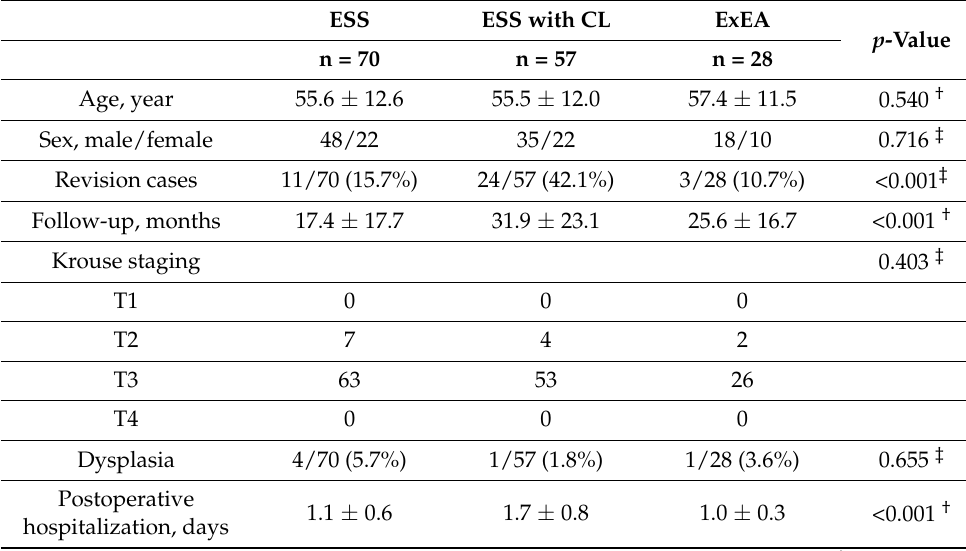
Table 1. Demographic and clinical characteristics of the